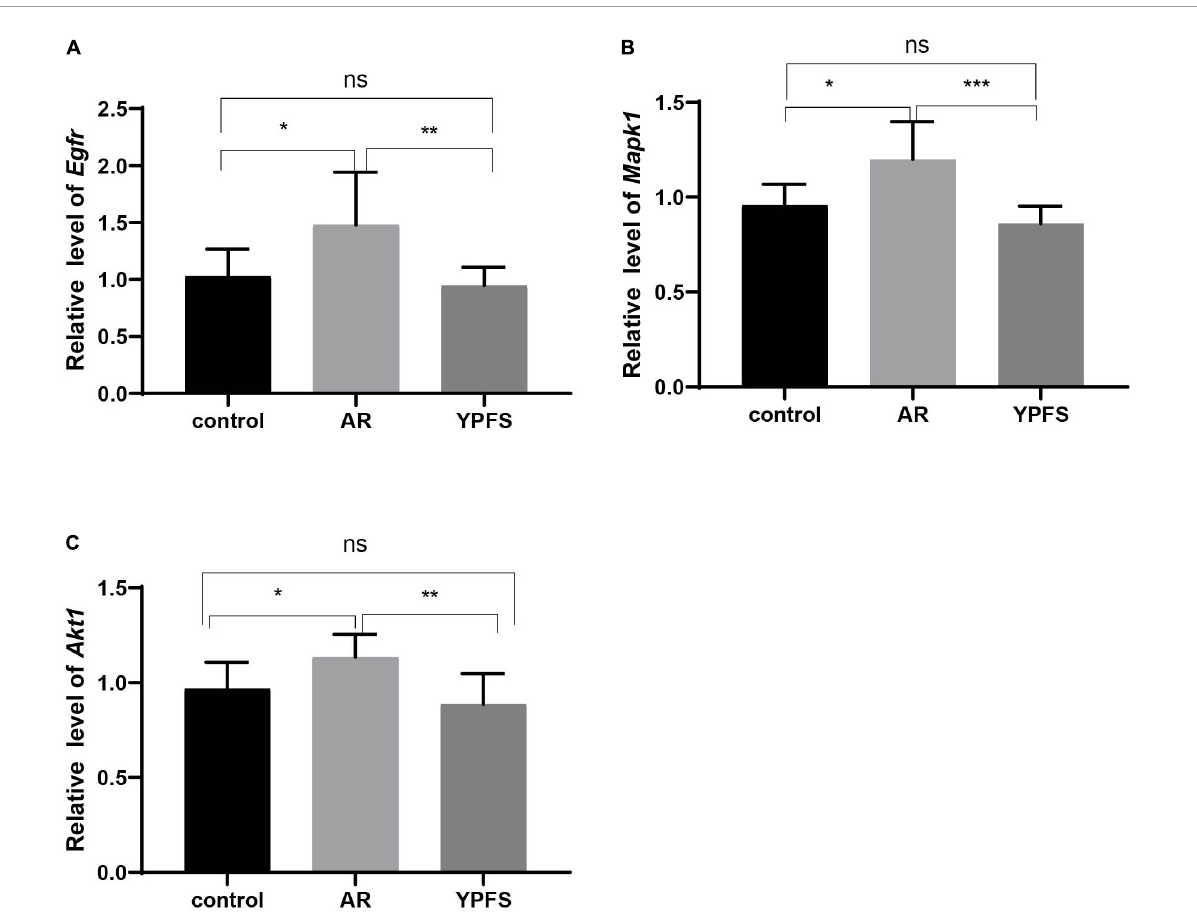
FIGURE7 Relative expression levels of Egfr (A) , Mapk1 (B) , and Akt1 (C) in the nasal mucosa of mice in the control group, ovalbumin (OVA)-induced AR group, and YPFS group. * P < 0.05, ** P < 0.01, *** P < 0.001; n = 6. YPFS, YU-Pingfeng San; AR, allergic